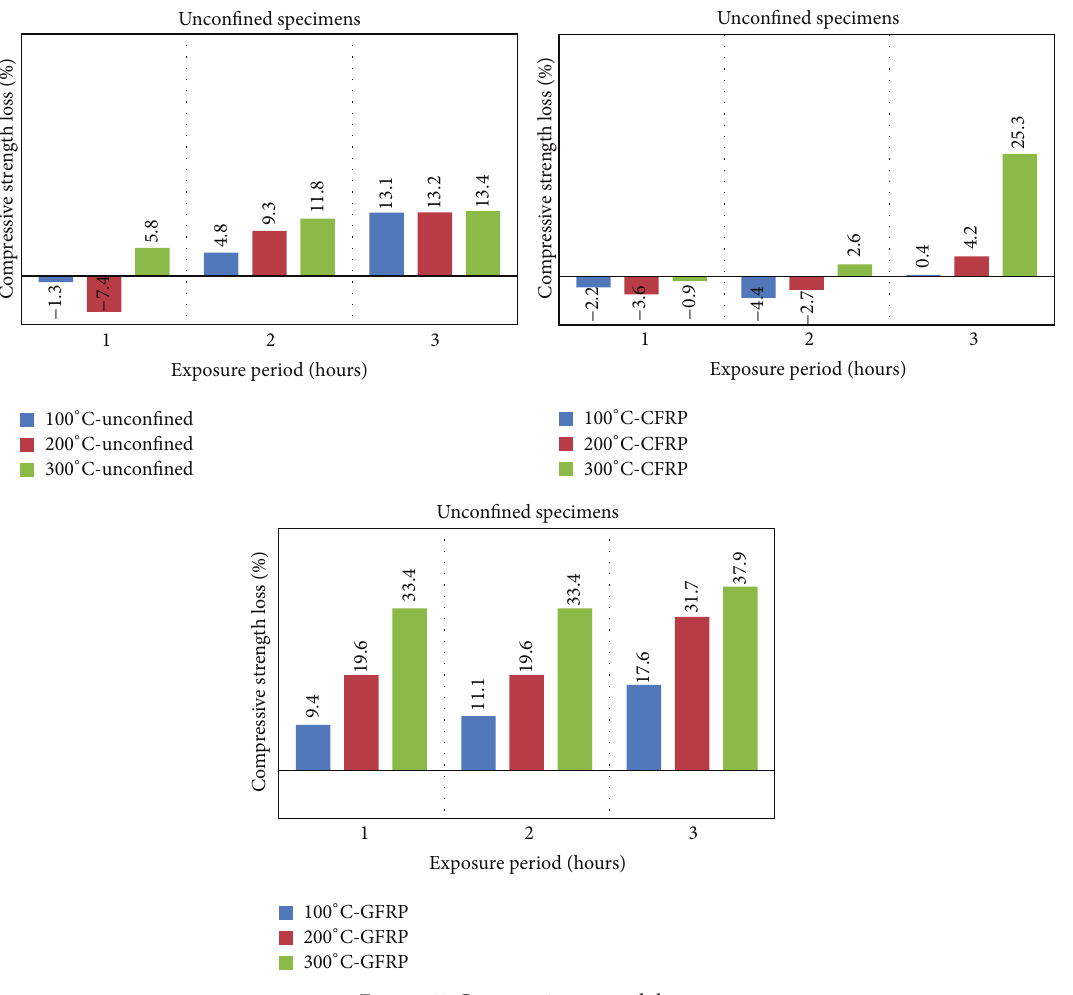
Figure 11: Compressive strength